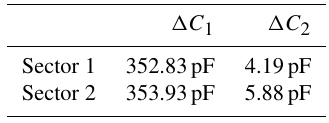
Figure 14. Field test results of capacitance against time for the very wet road surface condition. Table 6. Field test results for significant parameters of test drives on the second test route and for the very wet road surface